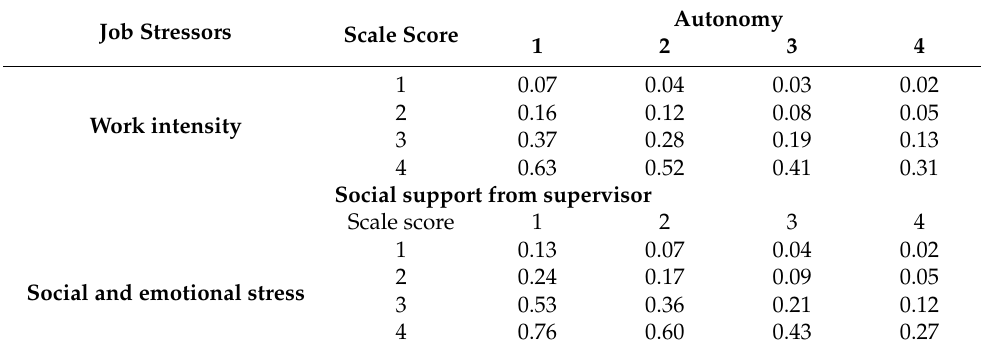
Figure 1. Relationship between job stressors and risk for psychological health impairment. Table 4. Scale score combinations and risks for psychological health